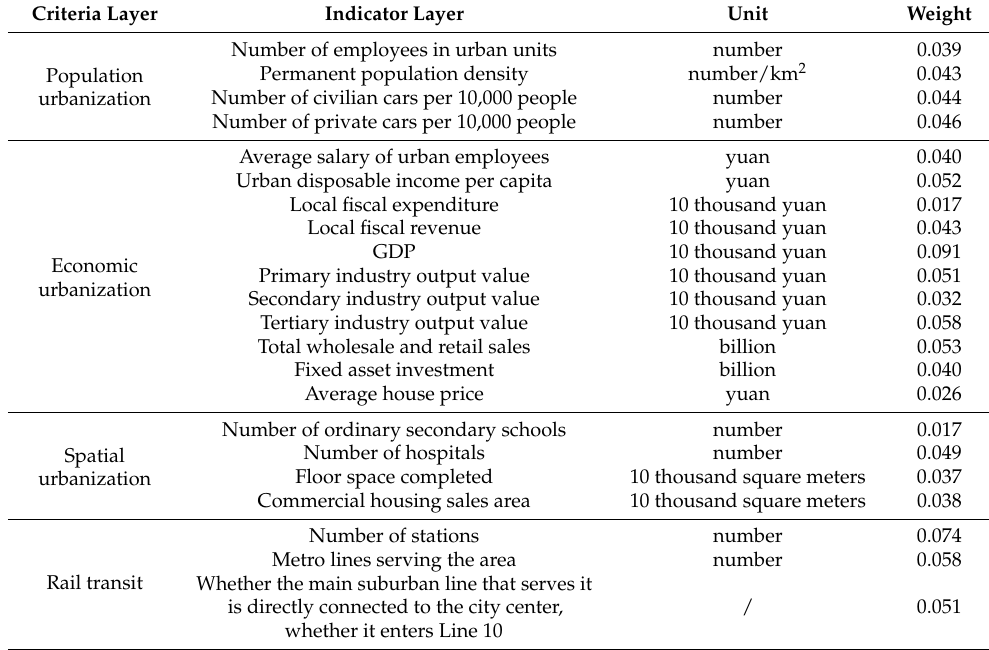
Table 2. Evaluation indicator